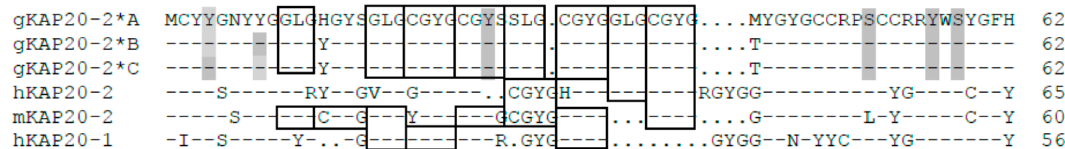
Figure 4. Alignment of KAP20-n sequences from goat, human, and mouse. The amino acid sequences are predicted from the nucleotide sequences, and are shown in one-letter code. Dashes represent amino acids identical to the top sequence, and dots have been introduced to improve the alignment. The length of each sequence is shown on the right. Residues that may be phosphorylated in the caprine KAP20-2 sequences are shaded. Boxes indicate the repeats of (G/S)LG and CGY(G/S). The goat sequences are indicated with a prefix “g”, while the sequences of human and mouse are indicated with “h” and “m”, respectively.